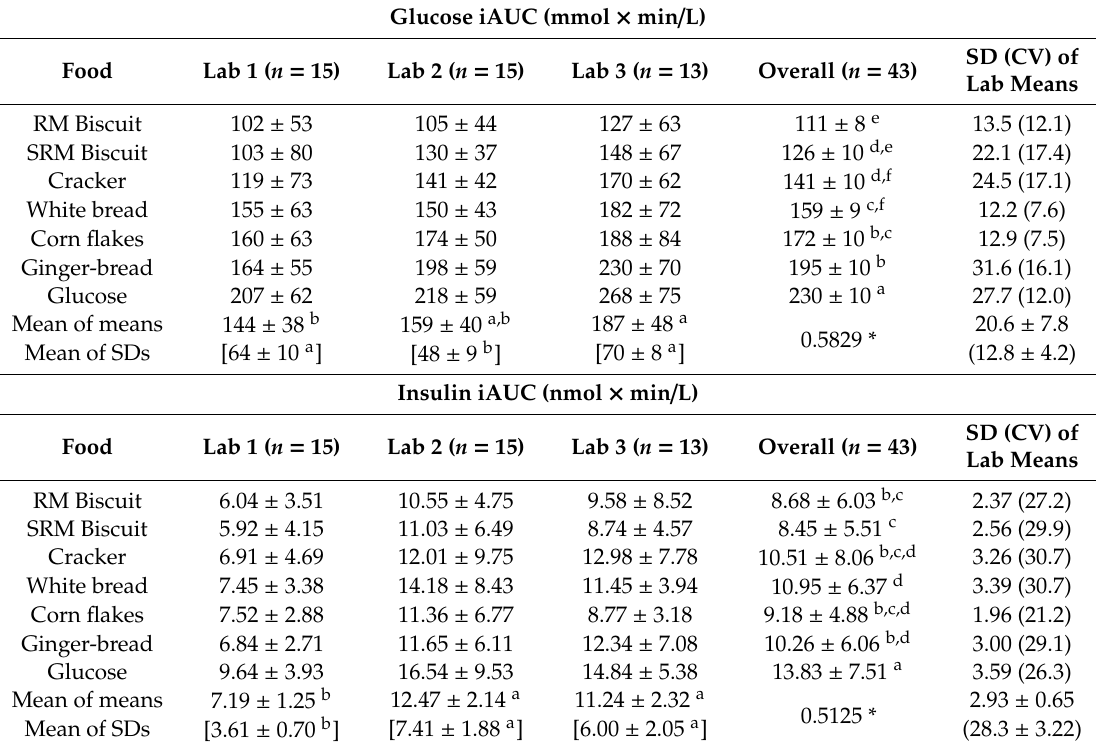
Table 4. Incremental areas under the curve (iAUC) for glucose and